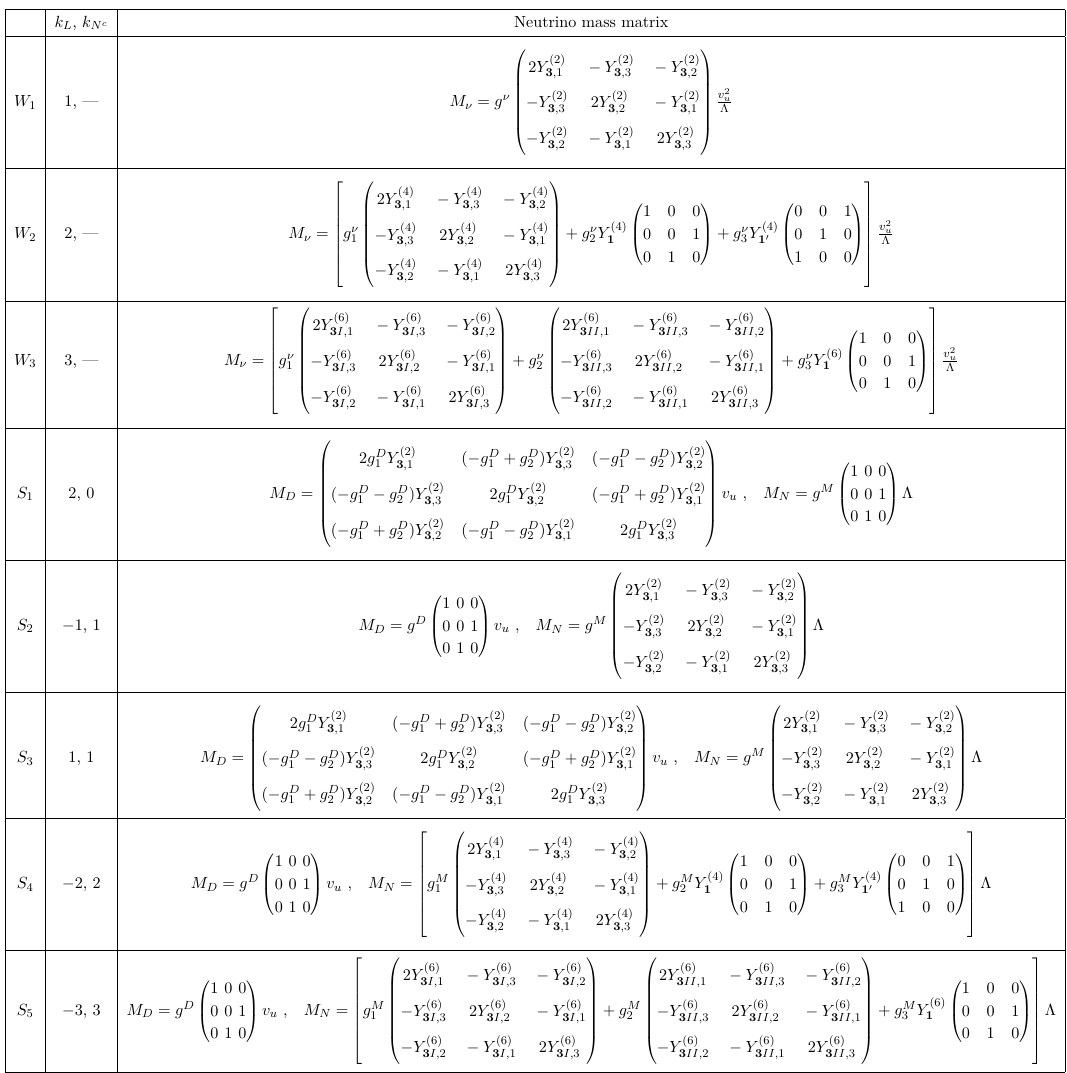
Table 3 . The predictions for the neutrino mass matrices, the neutrino masses are generated through the Weinberg operator for the models W and the type-I seesaw mechanism for the models 1 , 2 , 3 S 1 , 2 , 3 , 4 , 5 . Here we only present the cases which involve at most three real coupling constants in the effective light neutrino mass